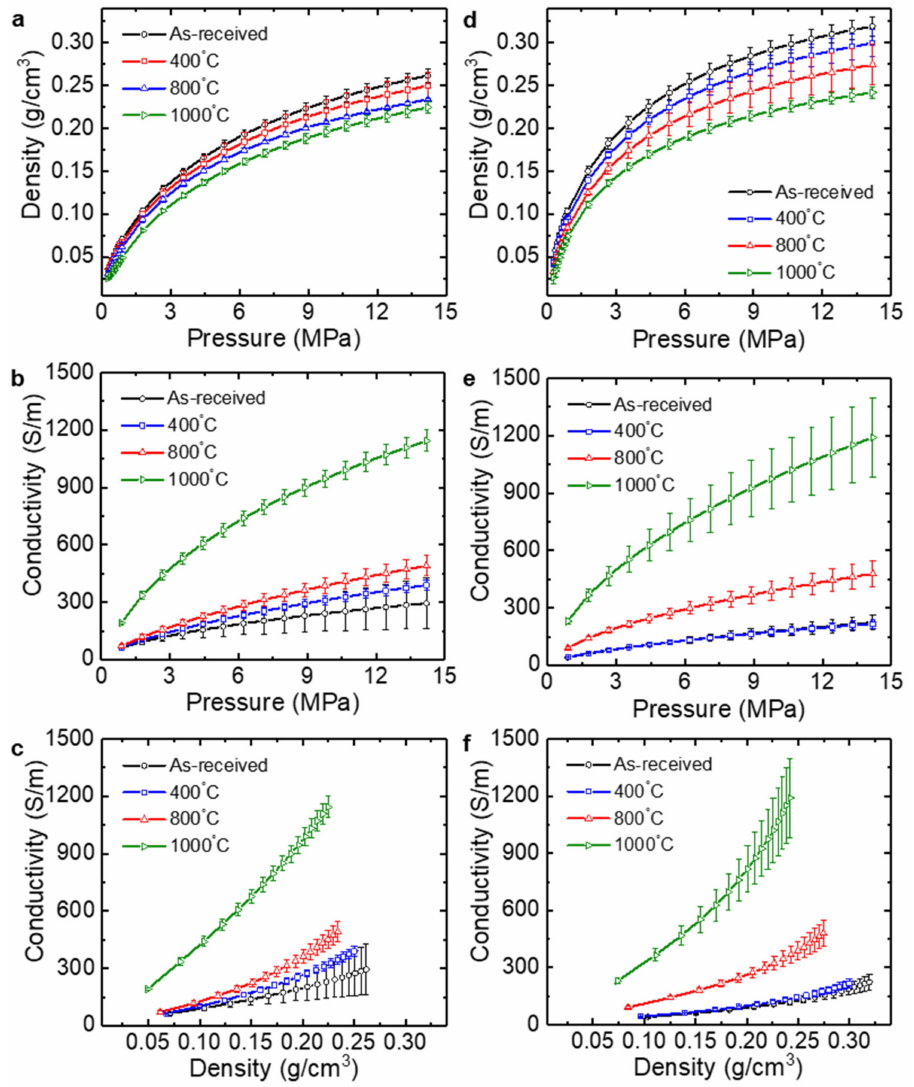
Figure 7. Electromechanical measurements of the ( a – c ) TGF600 and ( d – f ) V-50 rGO powders. ( a , d ) Density vs. pressure curve. ( b , e ) Electrical conductivity vs. pressure curve. ( c , f ) Electrical conductivity vs. density